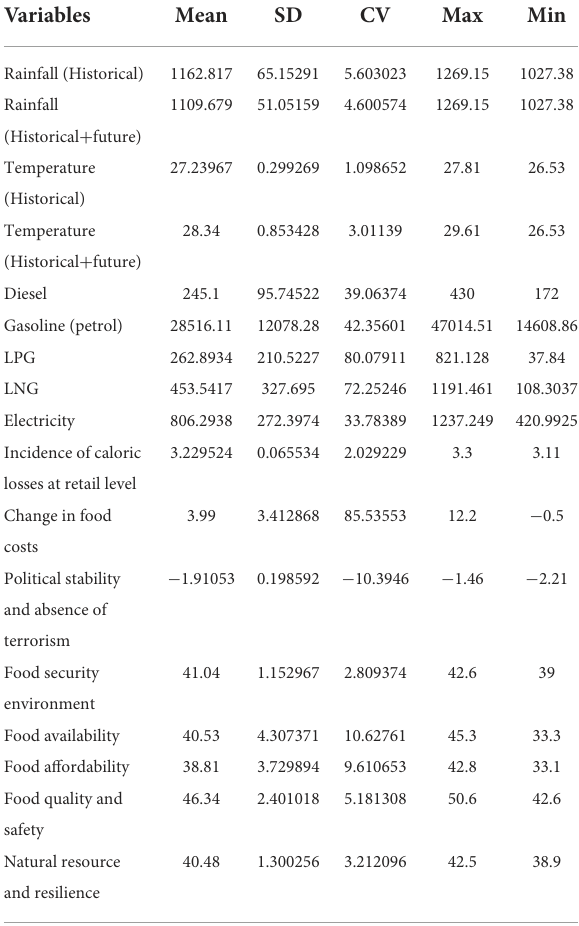
TABLE 2 Variations in data used in the study across Nigeria. Source: EIU, FAOSTAT, World Bank Climate Change Knowledge Portal,